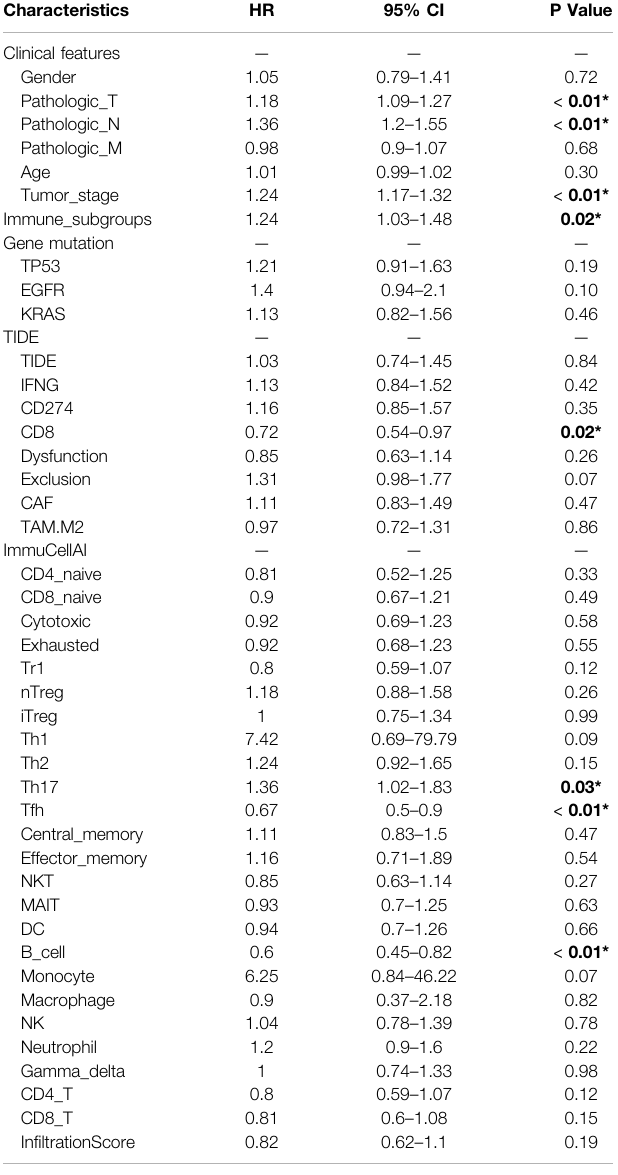
Bold value indicates that the differences between groups were statistically signi fi